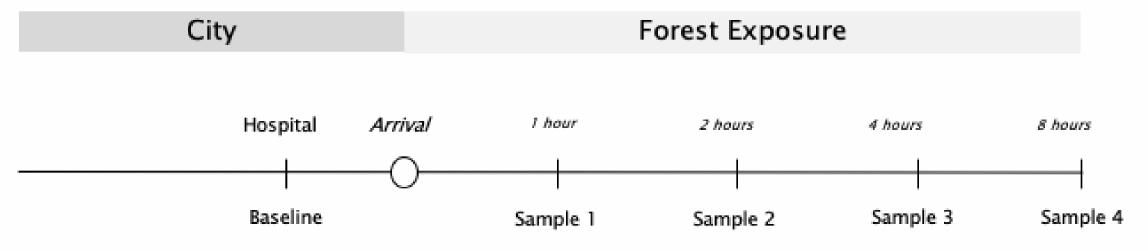
Figure 2. Sampling design